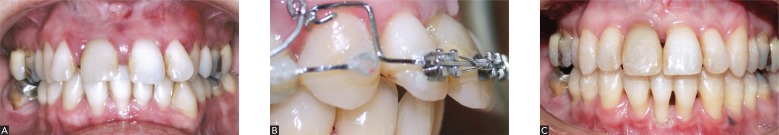
A) Clinical condition before treatment. B) Anchorage with wire bonded
directly to teeth during incisors intrusion and retrusion by means of
cantilevers. C) Final treatment outcomes